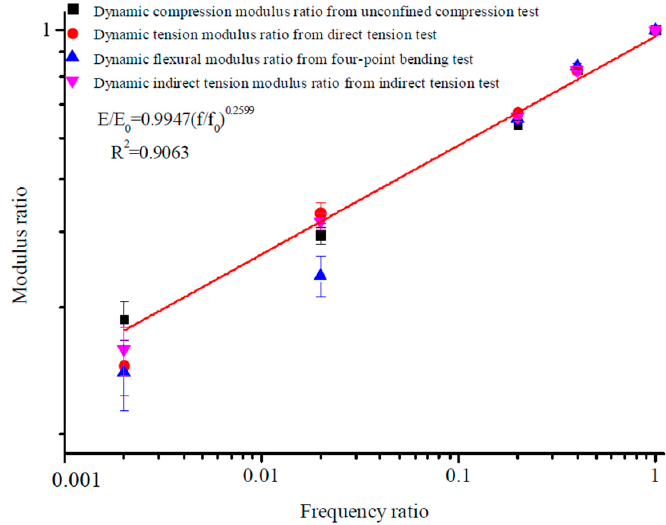
Figure 8. Standardization variation patterns for tension modulus ratio with frequency ratio.